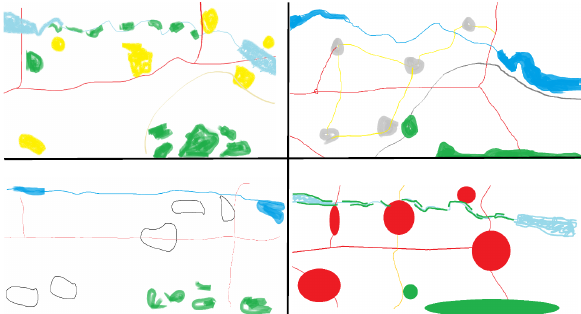
Figure 6. Sketch map examples (top and bottom left: novices, top and bottom right: experts)